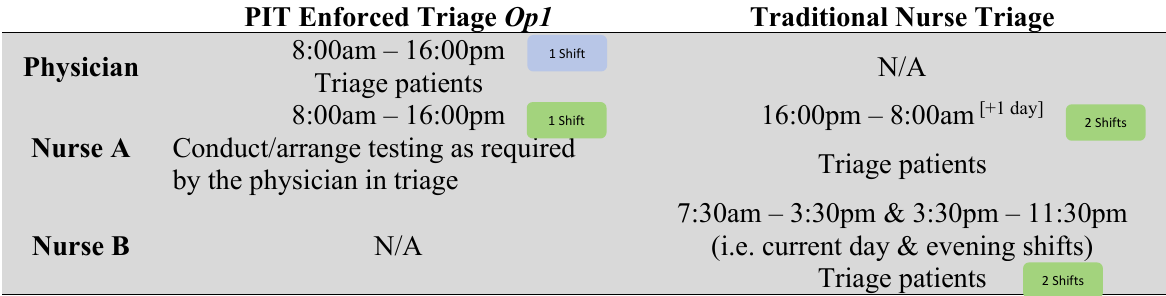
Allocation of human resources in physician and nurse in the triage model of Op1